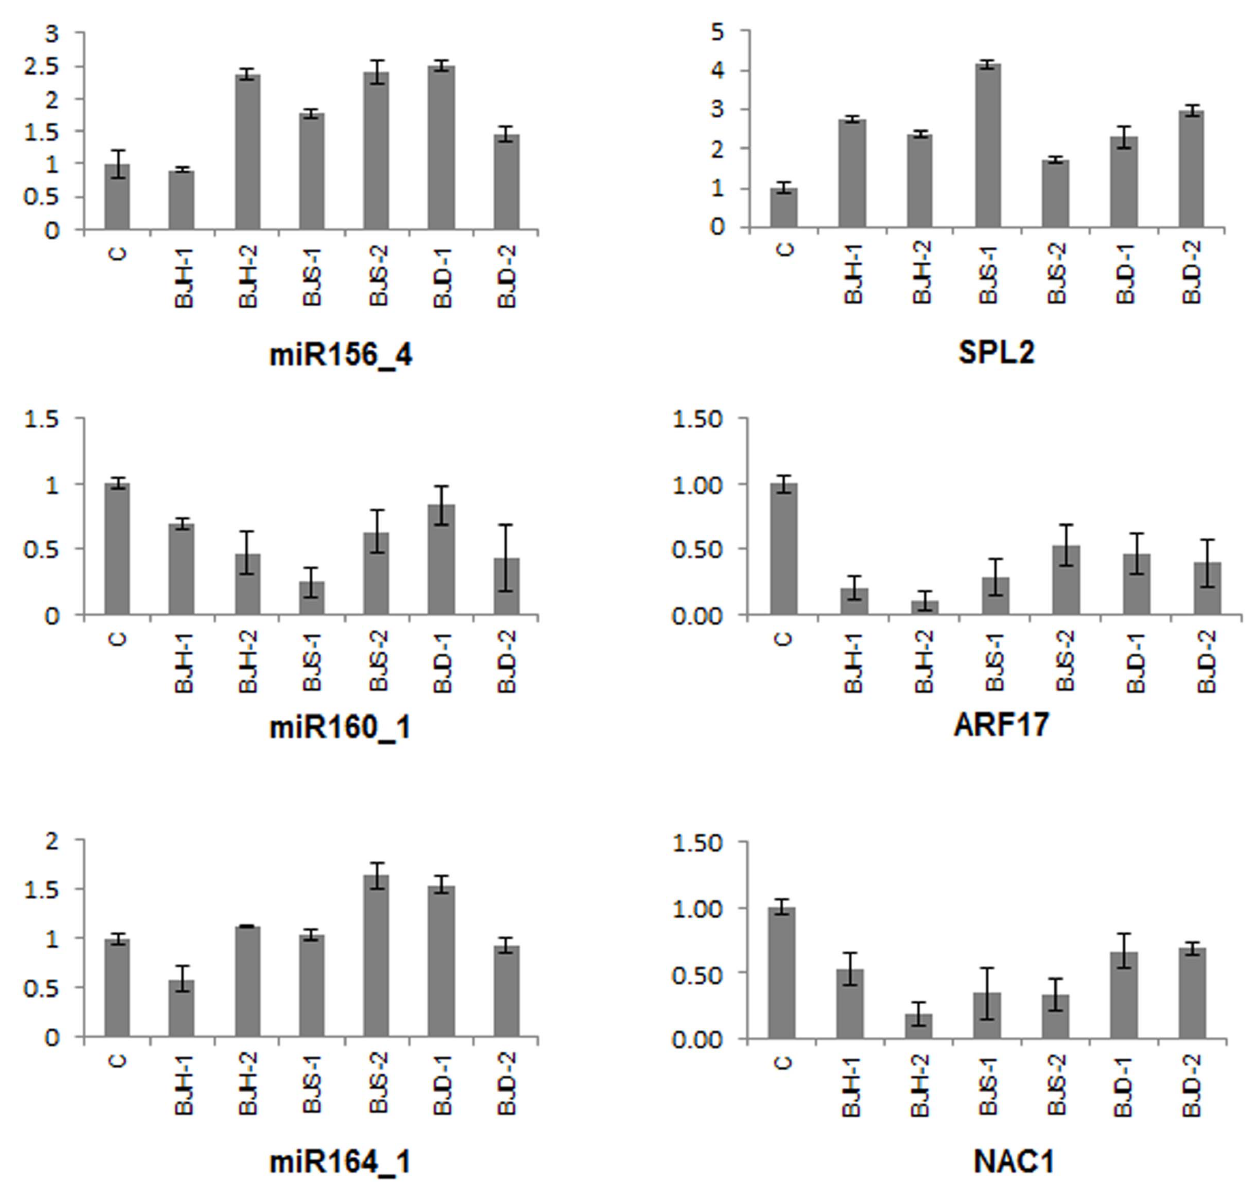
Figure 5. Expression profiling of miRNAs and their targets. The relative abundances of miR156, miR160, miR164 and their respective targets i.e., SPL2 (TC2101178), ARF17 (TC165518) and NAC1 (TC211305) was measured under different abiotic stress conditions using quantitative real time PCR. B. juncea seedlings were subjected for varied durations to either high temperature stress either at 35 u C (BJH-1) and 42 u C (BJH-2) or salinity stress at 150 mM NaCl (BJS-1) and 250 mM NaCl (BJS-2) or drought stress using 20% PEG (BJD-1) or 300 mM mannitol (BJD-2). The mean of three independent biological replicates is presented. doi:10.1371/journal.pone.0092456.g005 Figure S1 Size distribution of the putative small RNA population. Following elimination pipeline both the redundant (represented by striped bars) and the unique (represented by black bars) small RNAs were analyzed for their length (X-axis) versus their absolute number (Y-axis). Most of the small RNAs are in the size range of 20–24 nucleotides. (XLSX)